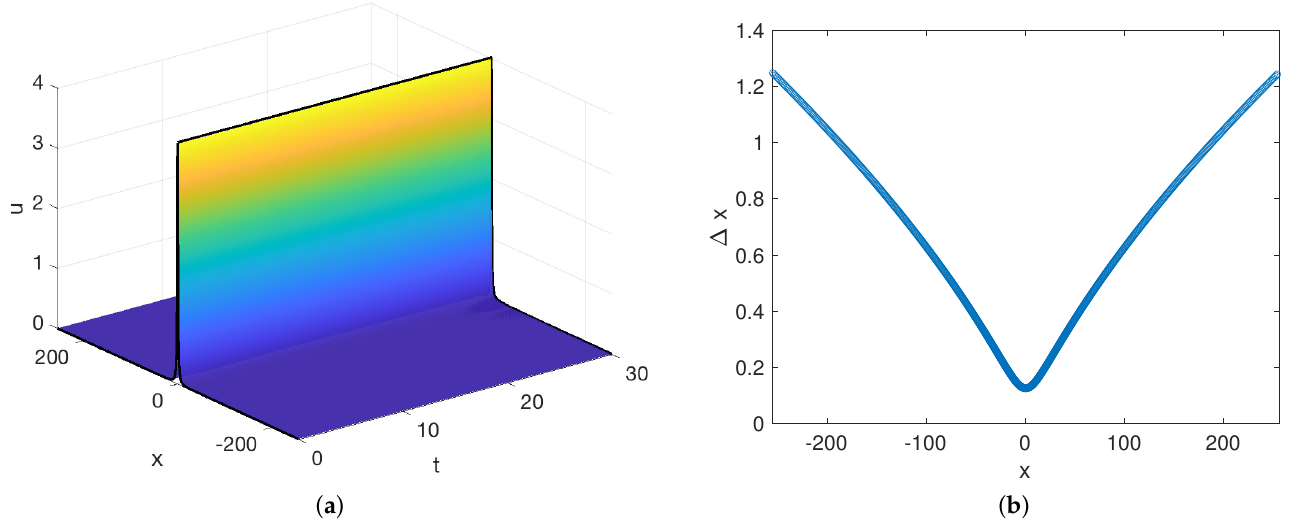
Figure 2. ( a ) The soliton solution propagated on a domain x ∈ [ − 256,256 ] . ( b ) The step-sizes used for the RBF-FD discretization used in the left simulation.